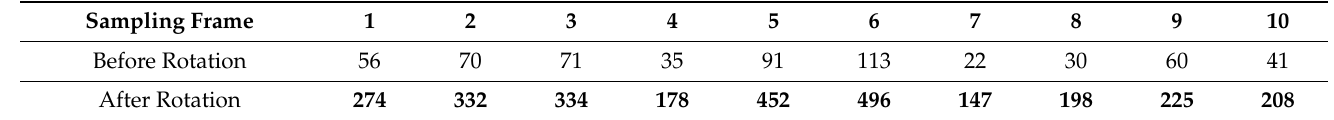
Table 4. Number of the matching points before and after rotation. The better results are highlighted in